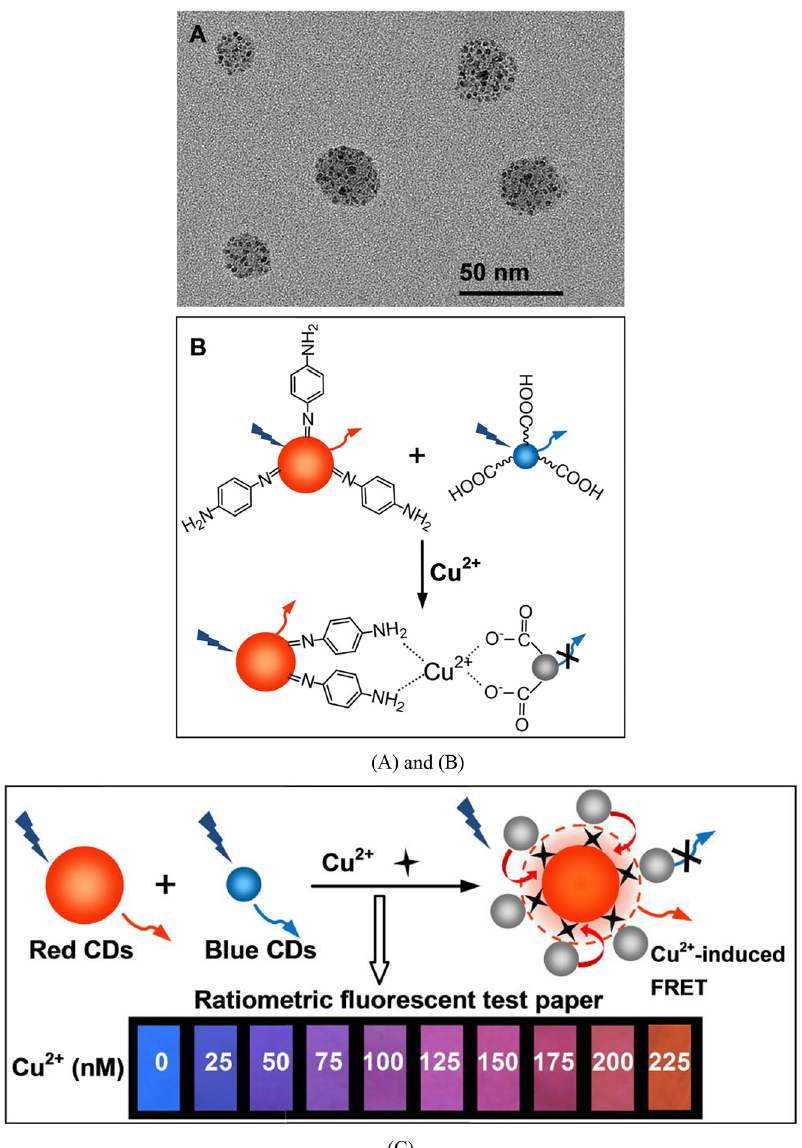
and 410 nm as reference.